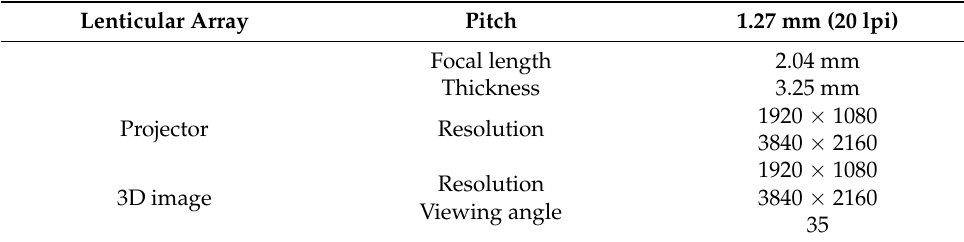
Table 1. Parameters of the lenticular array and